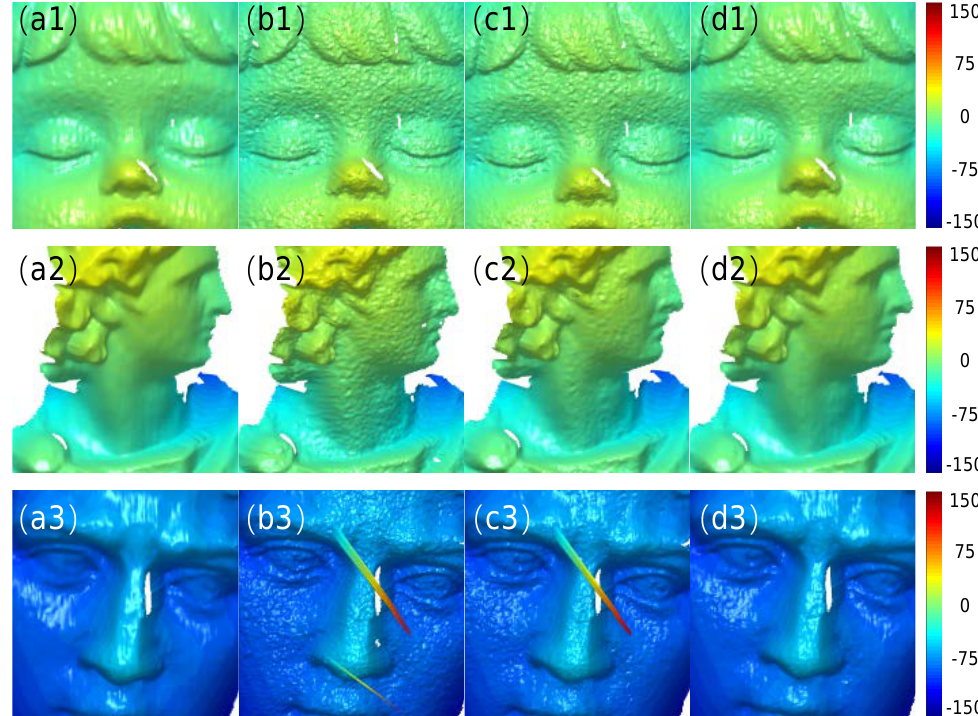
Figure 9. The 3D reconstruction of the NIR fringes obtained by ( a1 – a3 ) BM3D denoising followed by eight-step phase-shifting algorithm, ( b1 – b3 ) three-step phase-shifting algorithm, ( c1 – c3 )